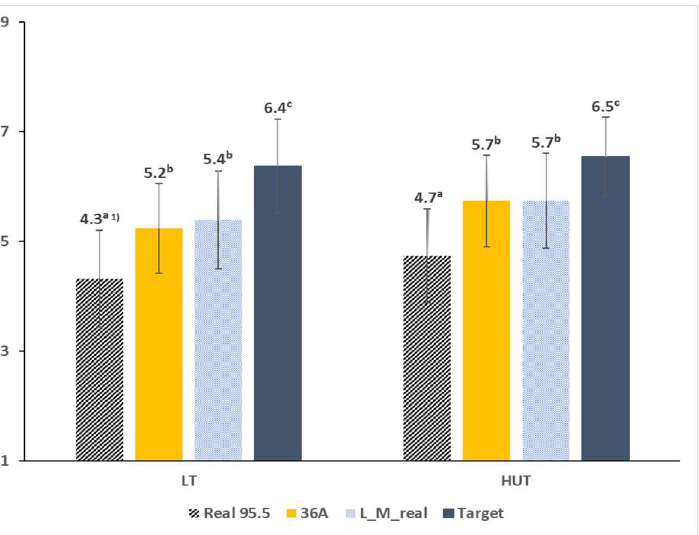
Figure 2. Mean overall liking scores of almond beverage samples in the lab condition test ( left ) and in the home-used test condition ( right ). 1) Within a test environment, different letters indicate significant differences between the mean overall liking values of samples ( p < 0.001).